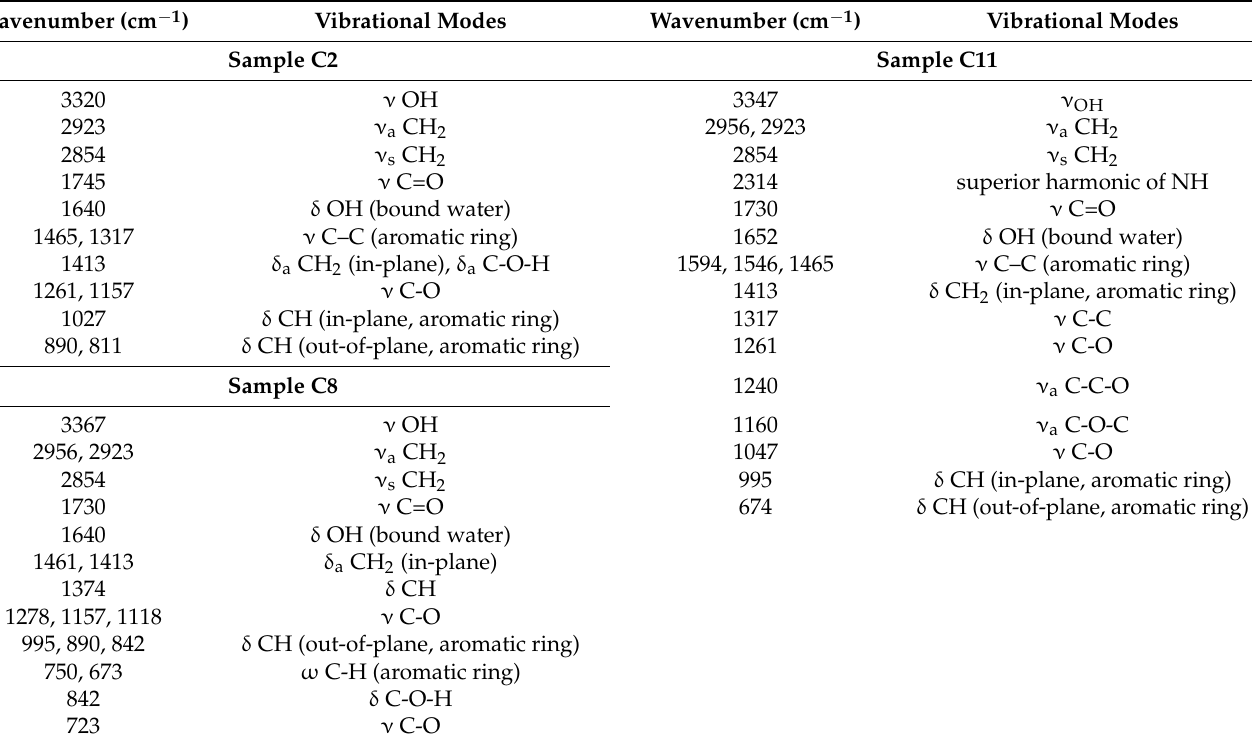
Table 1. Band assignment for the Attenuated Total Reflection- Fourier Transform Infrared (ATR-FTIR) spectra of samples C2, C8, and C11 reported in Figure 2.